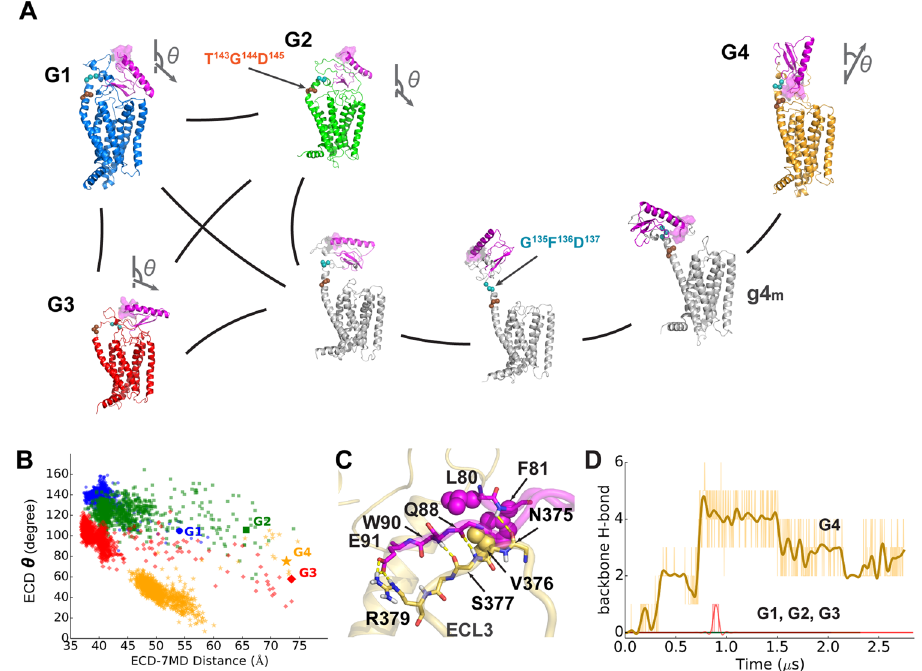
Figure 1. The open (G4) and closed (G1-G3) states of PAC1R. ( A ) Diagram of the PAC1R conformational transition from the MSM and transition-path theory. Vectors (N-to-C of helix 1 in ECD) show the ECD orientations, and the ECD N-term is highlighted with a purple surface. ( B ) Plots of the ECD tilt angle ( θ ) against the ECD-7TM distance. Starting points are labelled with larger markers. ( C ) The “zipper” between res. 80–91 and ECL3 in the open state. Key polar and hydrophobic side chains are shown in stick and sphere respectively. ( D ) Time evolution of the number of H-bonds defined in ( C ). The curves of G1-G3 mostly overlap. The styles of all figures in this work are consistent with Fig.